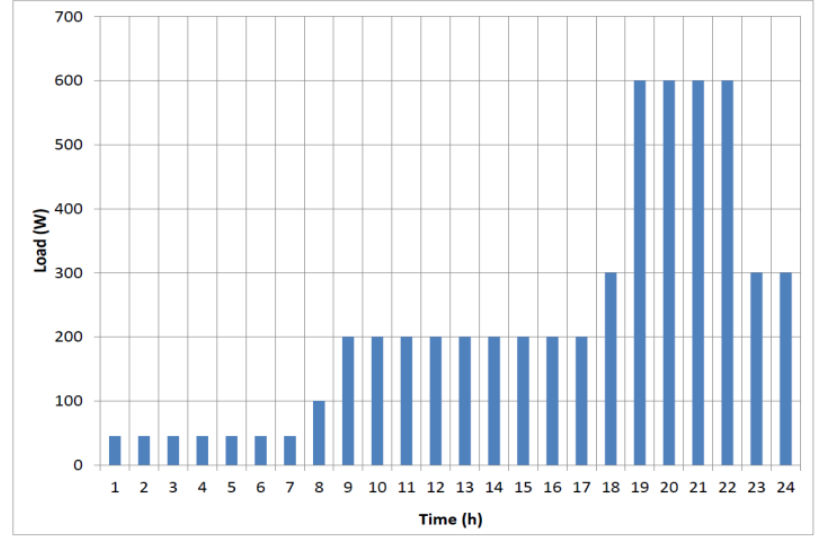
Figure 3. Hourly electricity load distribution during a day.